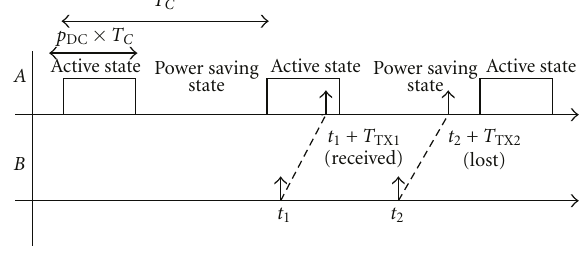
Figure 3: Duty-cycle parameters.